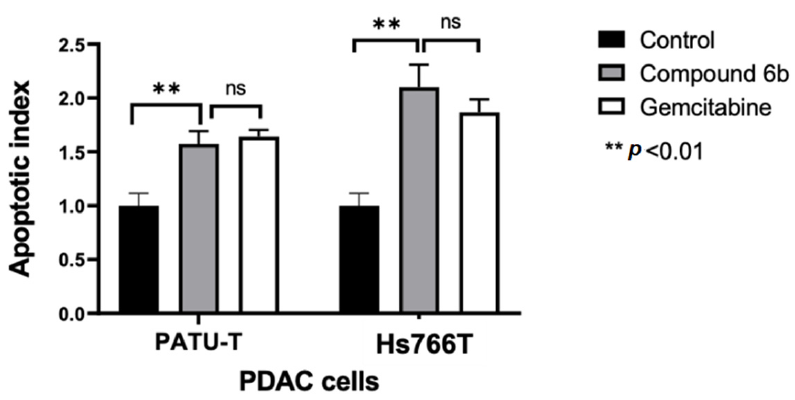
Figure 3. Effects of compound 6b on apoptosis induction in PATU-T and Hs766T pancreatic cancer cells. The apoptotic index was calculated by evaluating the annexin V-FITC fold change compared with control cells after 24 h treatment. Gemcitabine was used as a positive control. Columns: mean; bars: SEM ( n = 3). **: p < 0.01, significantly different compared with control; ns: not significant.